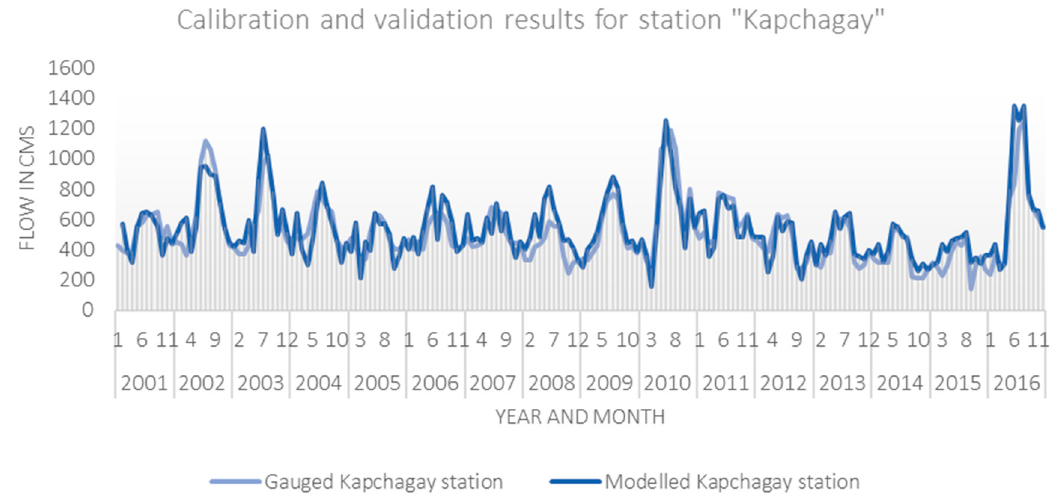
Figure A4. Calibration and validation results for station “Kapchagay”. Figure A4 Calibration and validation results for station “Kapchagay”. Figure A4 Calibration and validation results for station “Kapchagay”. Figure A4 Calibration and validation results for station “Kapchagay”.